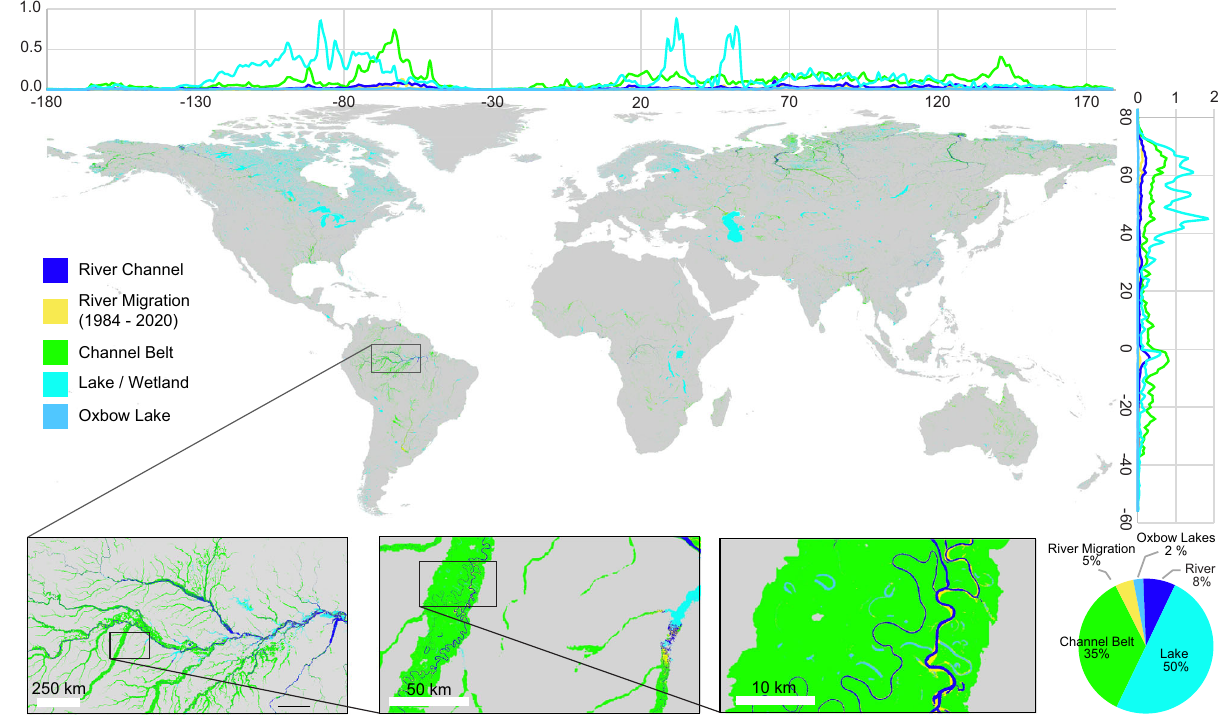
Fig. 4 | Global scale analysis of riverine and lacustrine environments — map showing the distribution of rivers, lakes/wetlands, smaller rivers or lakes, channelbelt andtheactivechannelbelt. Latitudinaland longitudinalplotsshow